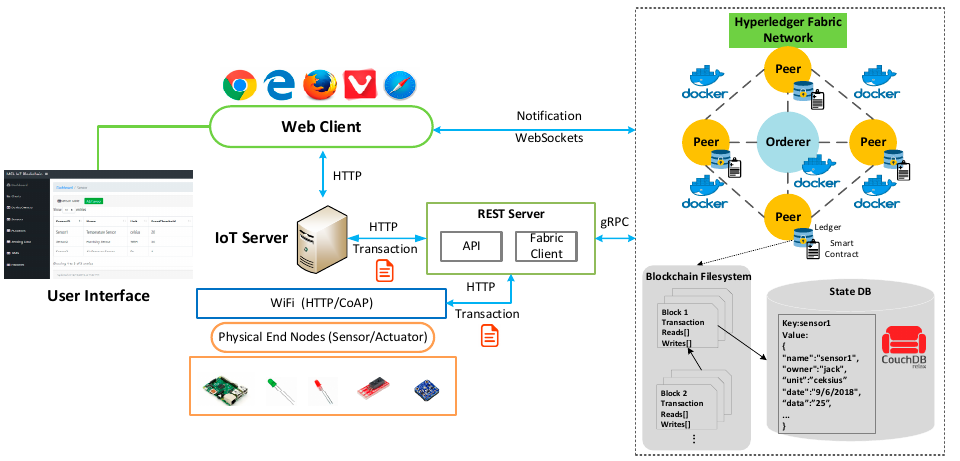
Figure 8 . IoT blockchain platform implementation and use case deployment. Figure 8. IoT blockchain platform implementation and use case deployment.